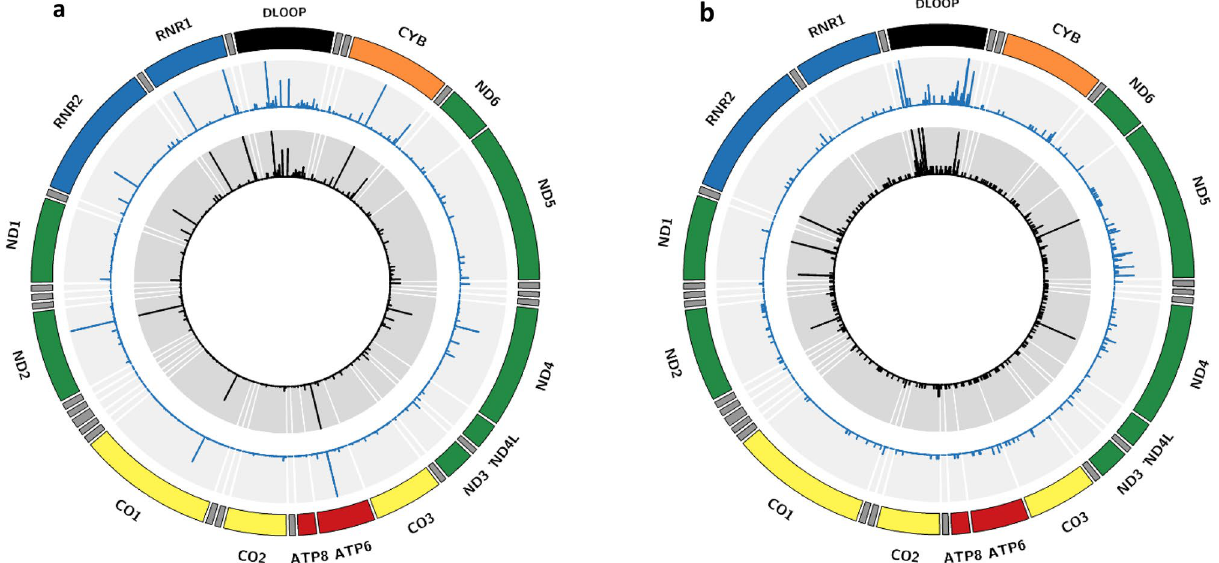
Figure 1. Comparison of homoplasmy ( a ) and heteroplasmy ( b ) between the 130 paired LCL (inner circle with black strokes) and whole blood (middle circle with blue strokes) samples from 130 Framingham Heart Study participants. The height of strokes represents frequency of a variation in mtDNA in the 130 participants. The major genes encoded by mtDNA is plotted in outer circle. LCL, lymphoblastoid cell